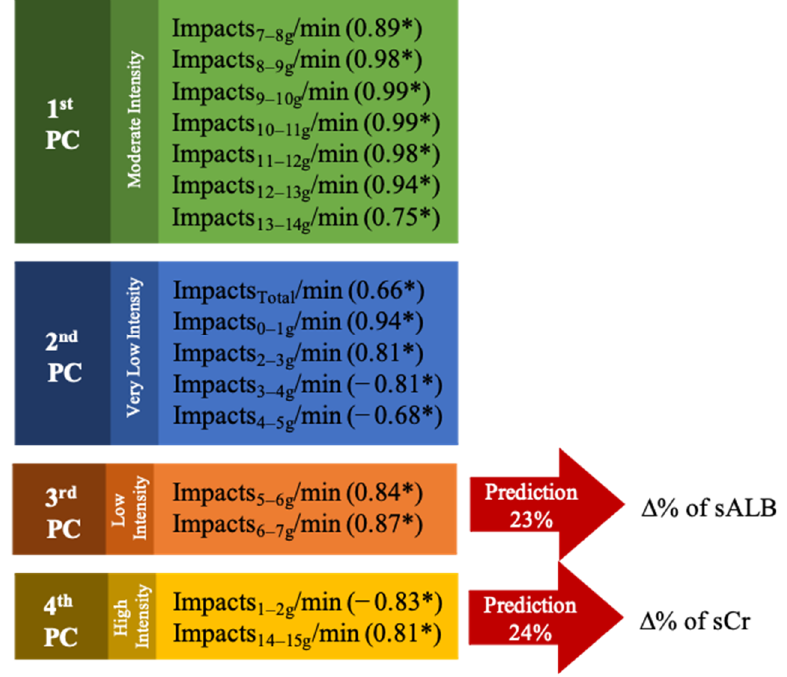
Figure 3. Principal component analysis extracted variables and loadings. * Loadings values.